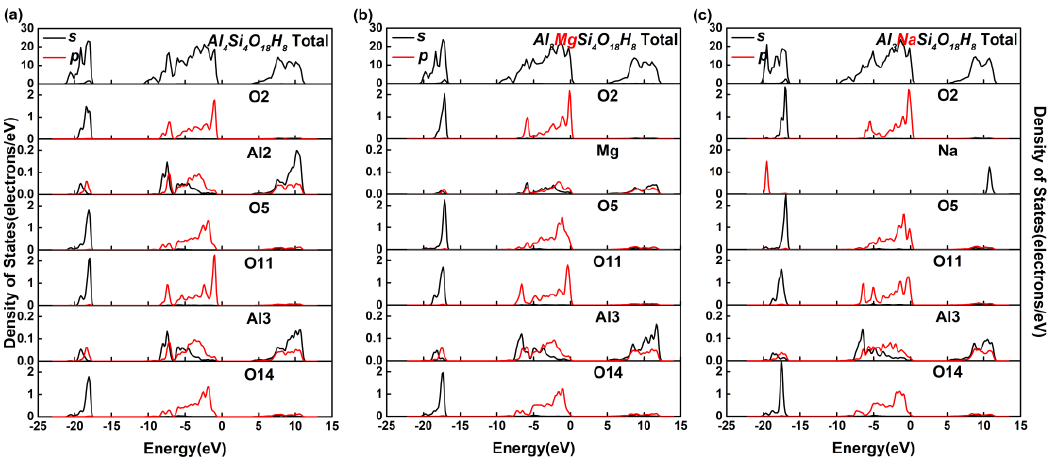
Figure 3. The total and partial density of states of the undoped, Mg-doped, and Na-doped kaolinite. ( a ) The undoped kaolinite (Al 4 Si 4 O 18 H 8 ), ( b ) the Mg-doped kaolinite (Al 3 MgSi 4 O 18 H 8 ), ( c ) the Na-doped kaolinite (Al 3 NaSi 4 O 18 H 8 ).